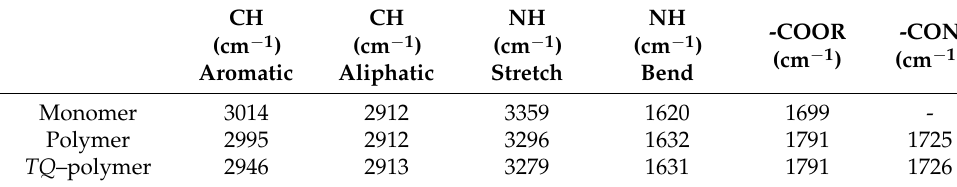
Table 1. FTIR spectral properties of the monomer, polymer, and TQ